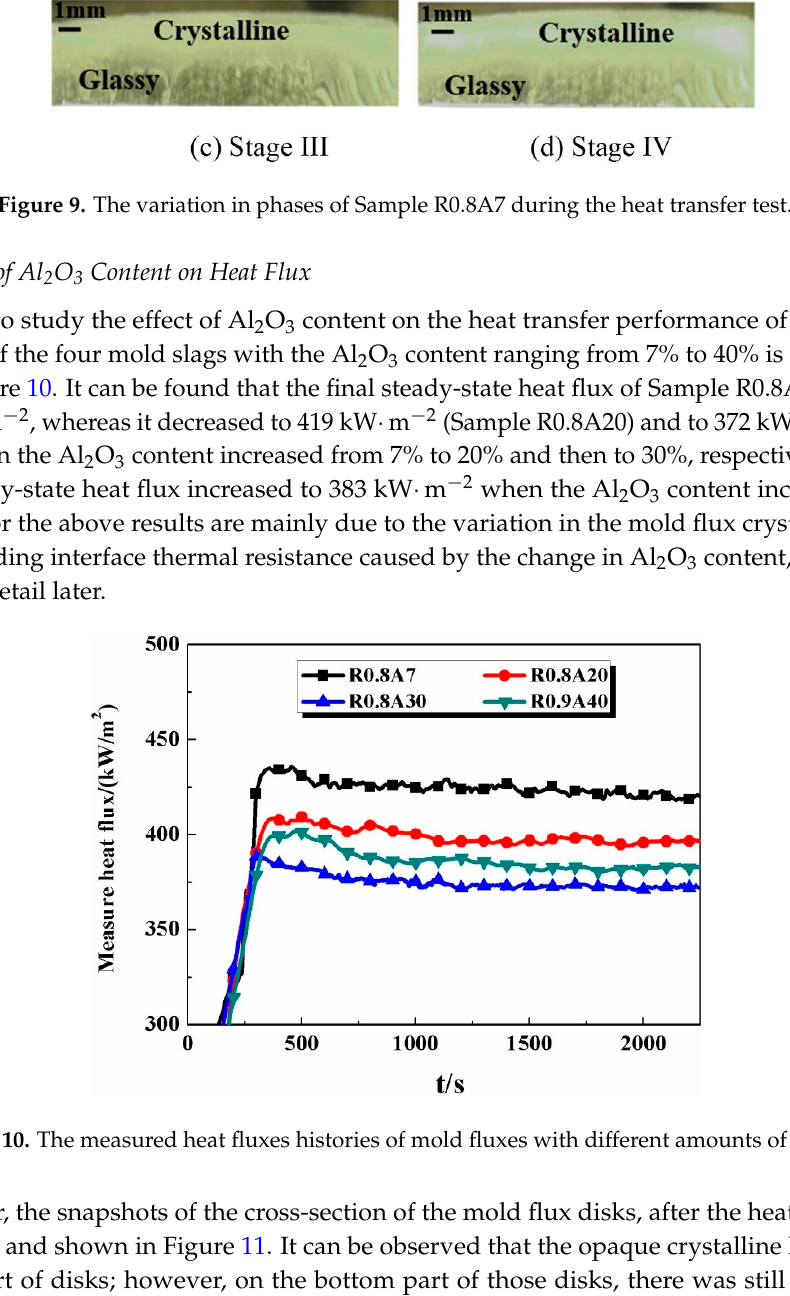
Figure 9. The variation in phases of Sample R0.8A7 during the heat transfer test.